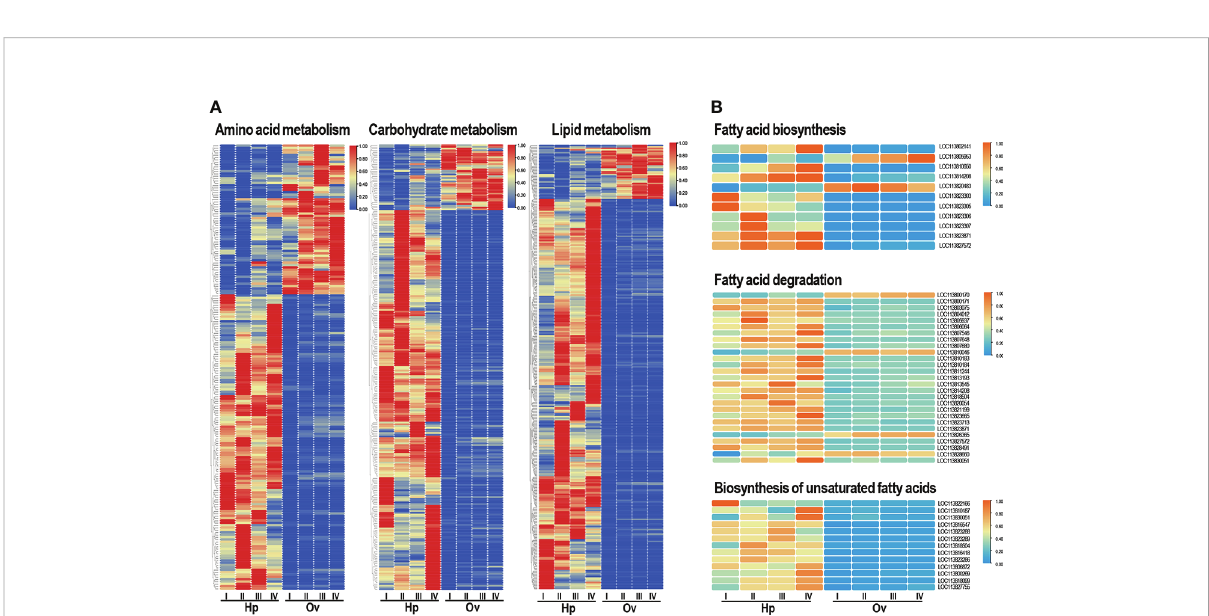
FIGURE 4 (A) KEGG analysis of three metabolic pathway transcripts up- and downregulated at different stages in the ovary and hepatopancreas. (B) Fatty acid metabolic pathway transcripts up- and down-regulated at different stages in the ovary and hepatopancreas. Orange and blue represent upwards and downwards shifts, respectively.